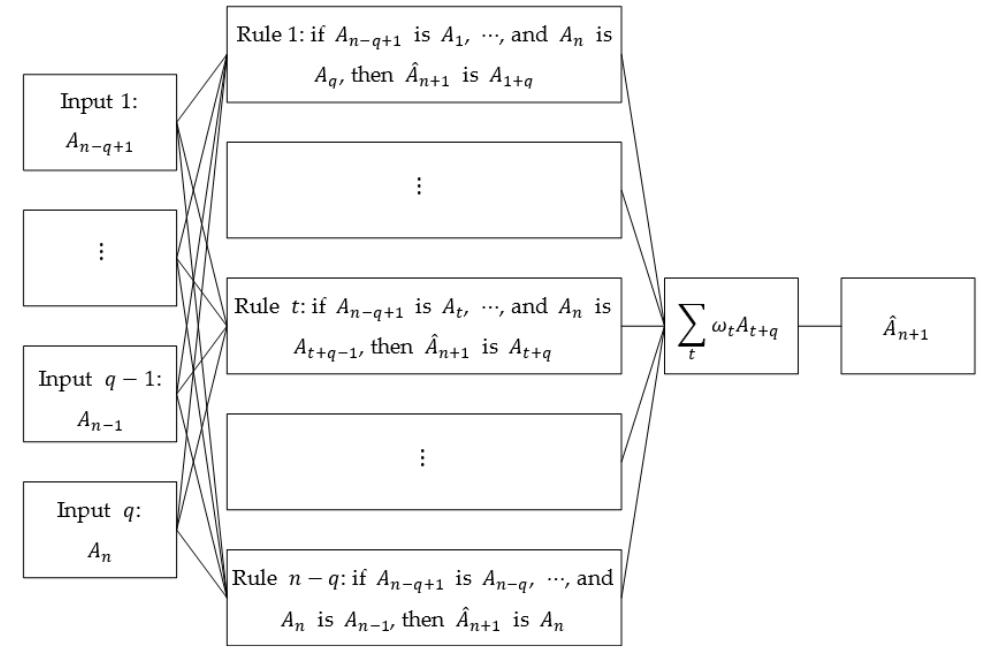
Figure 8. Fuzzy inference system.